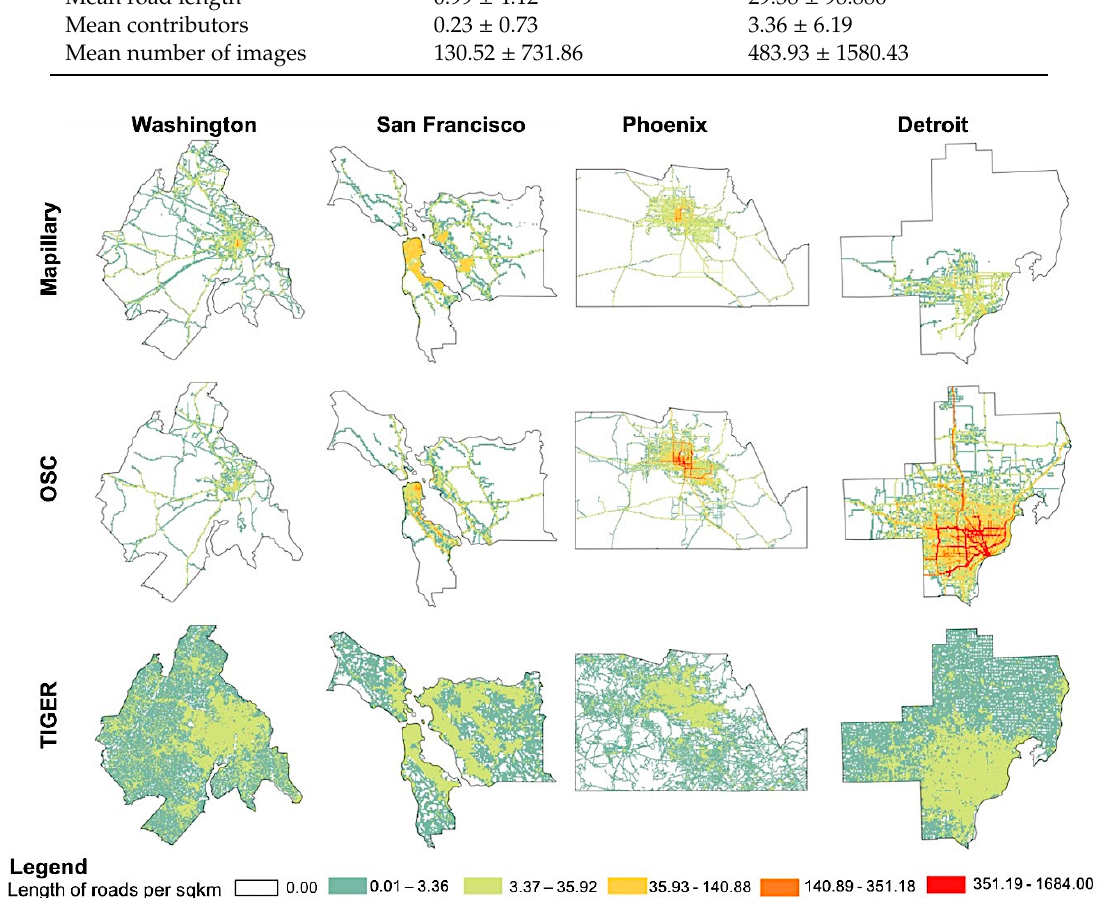
Figure 4. Total length of roads in kilometers per 1 × 1 km grid cell area.